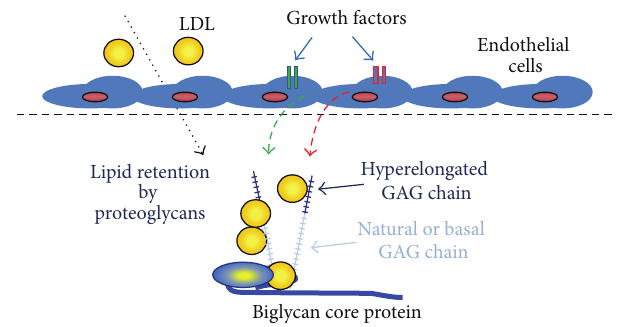
Figure 4: Role of growth factor mediated glycosaminoglycan (GAG) hyperelongation in the trapping of lipids in tissues. PGs have a basal or natural GAG chain length; however under the influence of growth factors the GAG synthesizing mechanism is activated leading to the increased expression of GAG elongation genes and ultimately the secretion of PGs with elongated GAG chains. These chains have increased binding to LDL (see text for details). Lipids trapped in tissues undergo chemical modifications which produce immunogens that initiate an inflammatory cascade and ultimately a chronic inflammatory disease